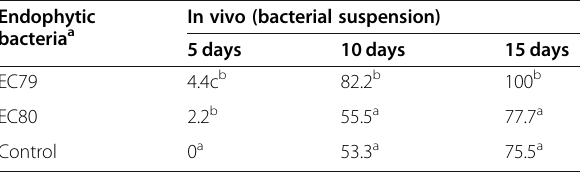
Table 3 Mean percentage of germinated seeds at 5, 10, and 15 days after bacterization with endophytic strains in